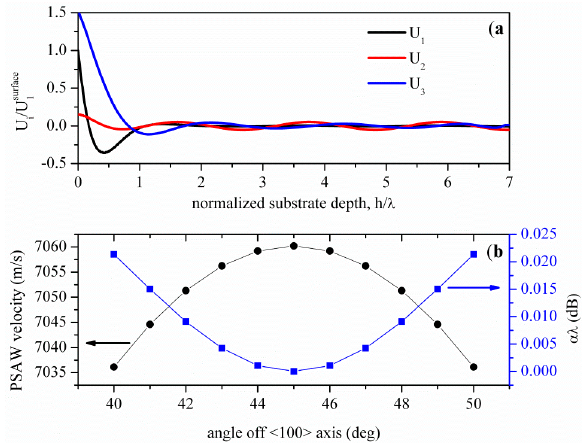
Figure 5. ( a ) Variation of the normalized shear and longitudinal displacement components with depth for the PSAW propagating at 49 ˝ off the <100> directions of the (001) plane of SiC; ( b ) the PSAWs velocity and propagation loss vs. the angle off the <100> direction of the (001) plane of SiC.